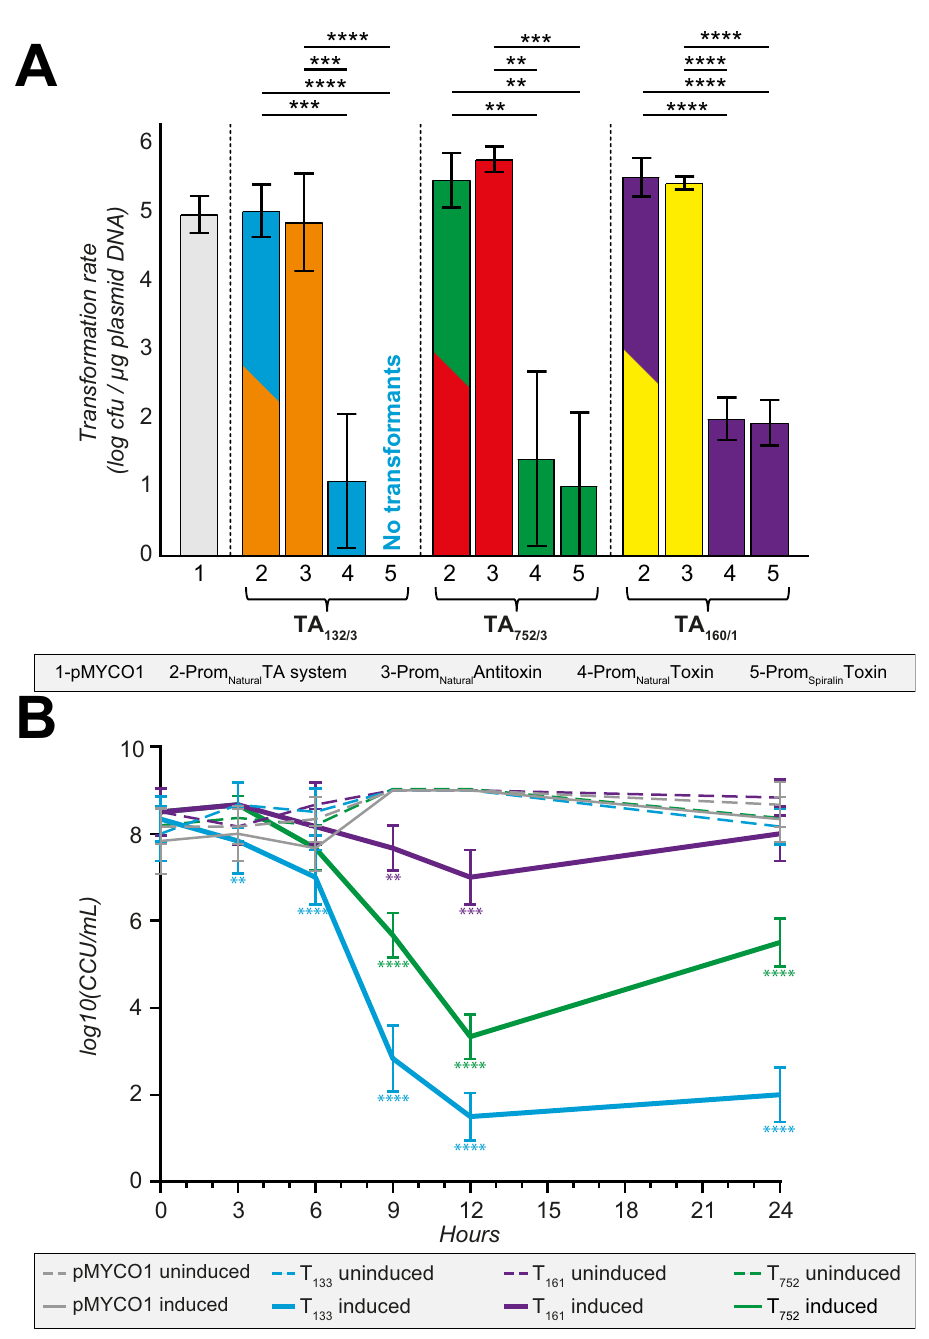
Fig 5. Effect of cloned toxins, antitoxins and TA systems on the transformation rate into M . capricolum subsp. capricolum . (A) M . capricolum subsp. capricolum ATCC 27343 T was transformed with different plasmid constructs harboring either entire TA operons (TA 132/3 , TA 752/3 and TA 160/1 ), individual toxins or antitoxins. Empty pMYCO1 plasmid was used as a positive control. Each column represents the mean of three independent biological replicates and bars indicate standard deviations. Significance is indicated ( �� p � 0.01, ��� p � 0.001, ���� p � 0.0001). (B) M . capricolum subsp. capricolum ATCC 27343 T was transformed with different plasmid constructs harboring the toxins (T 133 , T 752 and T 160 ) under the control of an inducible promotor. Empty pMYCO1-Chlo R plasmid was used as control. Graphs represents the mean of three independent biological replicates and bars indicate standard deviations. Significance is indicated ( �� p � 0.01, ��� p � 0.001, ���� p �